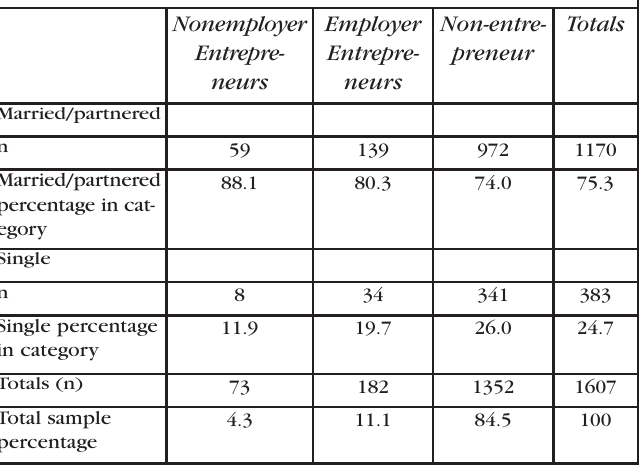
Table 4. Composition of Sample by Marital and Entrepreneurial Category